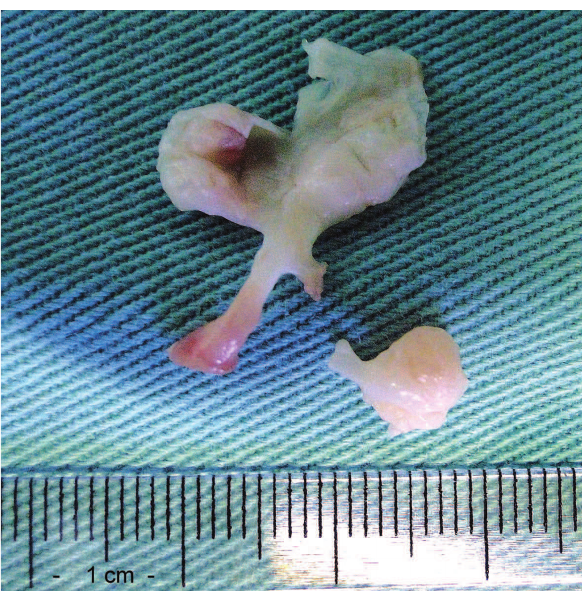
Fig. 3. Folheto mitral acessório ressecado demonstrando o músculo papilar acessório (separado) e as cordoalhas rudimentares